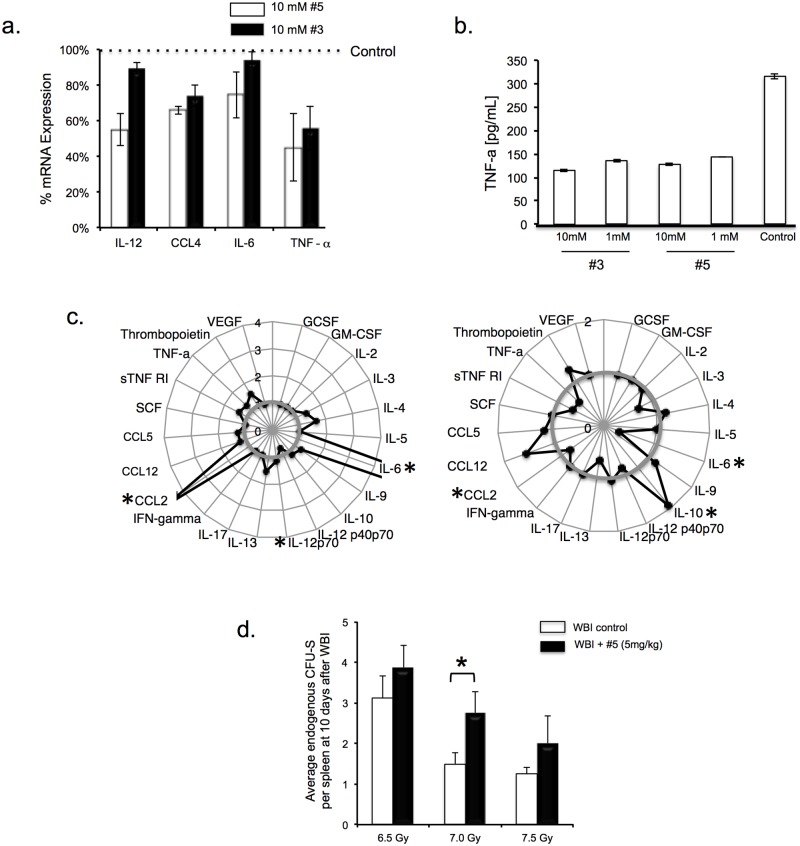
Successfully mitigated mice show favorable immune reconstitution and inflammatory rebalancing.(a) mRNA levels of various cytokines assessed by RT-PCR in bone marrow derived macrophages treated with 10μM #3 or #5 1 hr after 100ng/ml LPS and assayed at 6hrs. All except IL-6 were significantly decreased (P<0.05). (b) TNF-α production at 24hrs by inflammatory peritoneal exudate cells treated in vitro with 100ng/ml LPS followed at 1hr by 1 or 10 μM #3 or #5 or diluent. (c) Bone marrow cells were removed from C3H mice 30hrs after WBI (LD70/30–7.725Gy) or sham irradiated, with compound #5 or diluent given 6 hrs before harvest. After overnight culture, supernatants were tested for cytokines by multi-arrays. The spider plots show changes after WBI alone (left) compared to control (value = 1 in grey) and WBI plus compound #5 (right) compared to WBI alone (value = 1 in grey). (d) Compound #5 (5mg/kg s.c. at 24 hrs after WBI) increases the number of endogenous CFU-S per spleen at day 10 after the WBI. (*p<0.05)